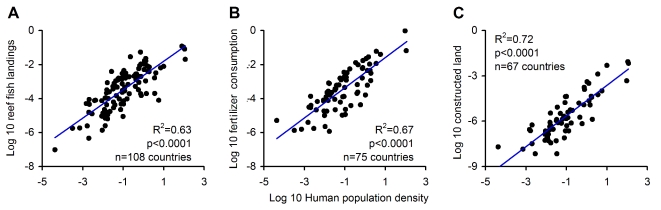
Surrogates for human population density near reefs.To assess the likely mechanism mediating the effect of human population density on reef fish biomass, we analyzed the relationships between human density near reefs and (A) fishing, (B) nutrient loads, and (C) habitat alteration. Fishing was estimated from reef fish landings reported to the Food and Agriculture Organization (http://www.fao.org/fishery/statistics/software/fishstat). For each country with coral reefs, we averaged reef fish landings between the years 1997 and 2001. Reef fish stocks were discriminated by classifying each of 1,472 stocks reported to the Food and Agriculture Organization as reef- or non-reef-associated using the Internet and other sources (http://www.fishbase.org). Nutrient load was quantified as fertilizer consumption using data obtained from the World Development Indicators database (http://www.worldbank.org/data). Finally, habitat alteration was quantified as the area of modified land indicated in the Global Land Cover 2000 dataset (http://ies.jrc.ec.europa.eu/global-land-cover-2000). Technical note: For purposes of comparison all variables were standardized by country area and area of reef. To control for type I errors arising from standardizing data by a common factor, significance levels were calculated by Monte-Carlo simulation, in which the slopes of the plots were calculated for each of 10,000 iterations in which standardization was done with random country areas and reefs, and then determining the fraction of “random” slopes above the true slope [51].